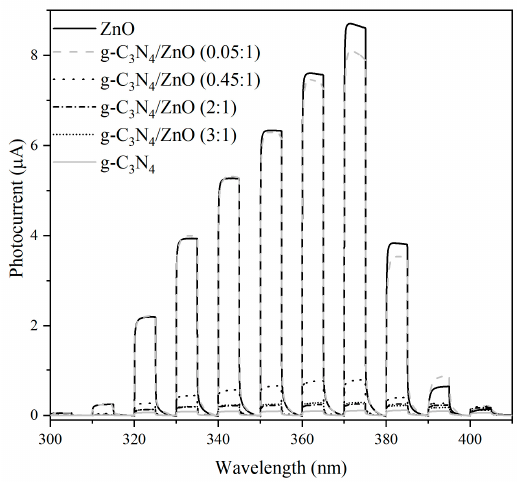
Figure 7. Photocurrent generation at electrodes made of ZnO, g-C 3 N 4 , and g-C 3 N 4 /ZnO recorded at 1 V vs. Ag/AgCl in deoxygenated 0.1 M KNO 3 .